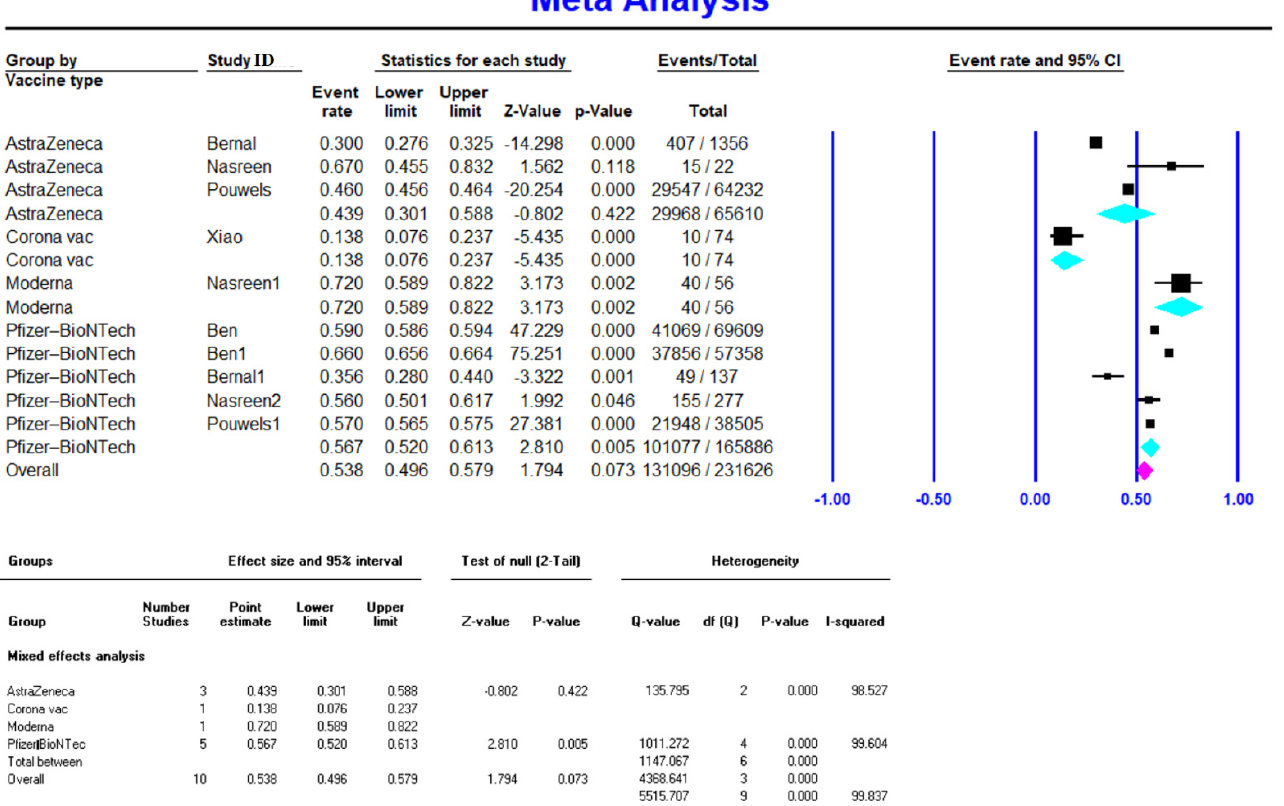
Figure 2. Effectiveness of COVID-19 vaccines after the first dose against Delta variant infection.